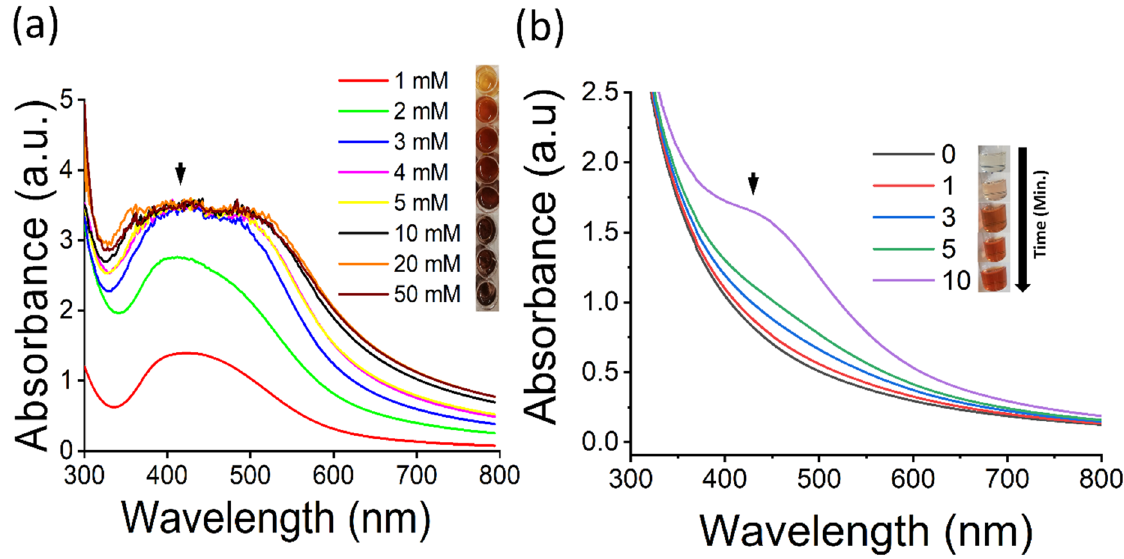
Figure 1. UV–Vis spectrum analysis. ( a ) UV–Vis spectrum of SL-SpNPs using various SN molarities (1–5, 10, 20, 50) mM with sunlight irradiation for 1 h. All samples show absorbance peaks between 400 and 450 nm as shown by arrow. ( b ) The synthesis of SL-SpNPs (with 10 mM SN) with varying times of incubation. UV–Vis analysis shows the highest value after 10 min of incubation